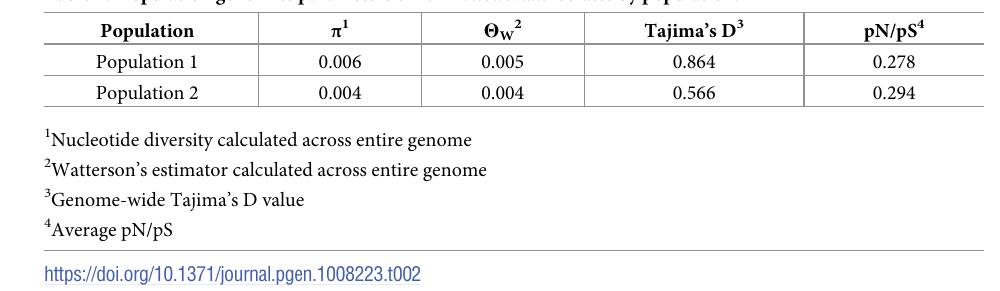
Table 2. Population genomics parameters of 172 P . nodorum isolates by